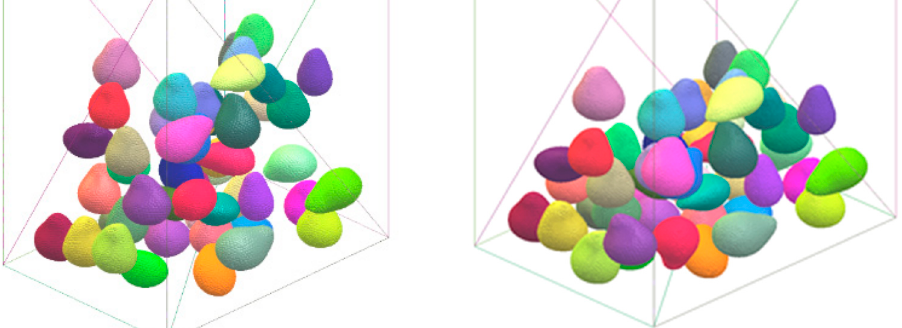
Figure 5. Two snapshots showing how the random packing of shapes occurs in the Discrete Element Modelling approach YADE. Progress in the model occurs until the shapes can no longer “settle”, which means that no shape will move further under the influence of gravity alone.